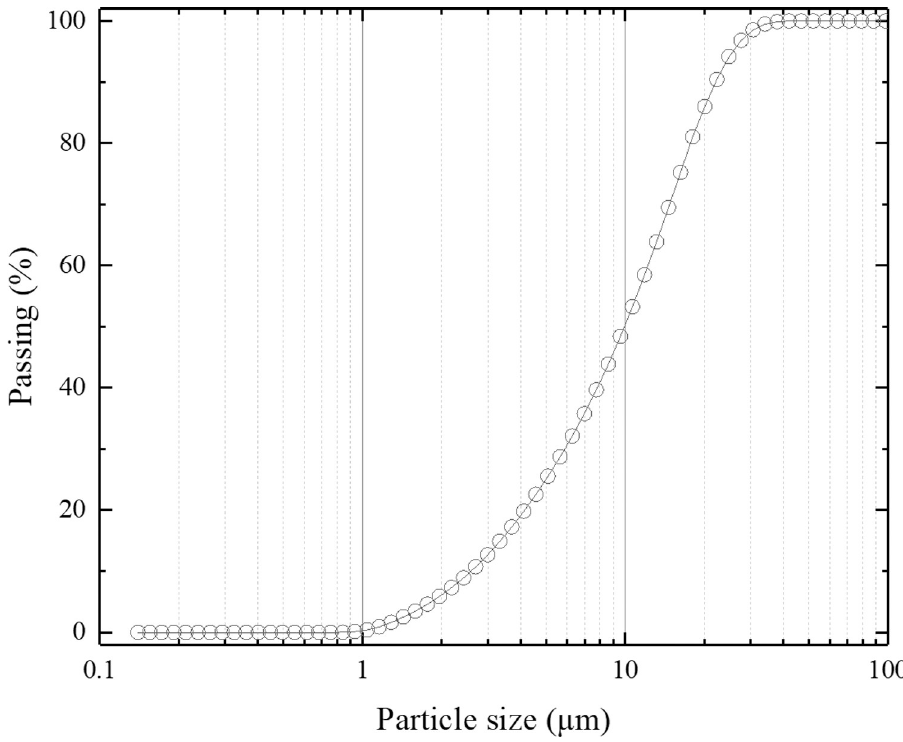
Fig 5. Suspended particle gradation